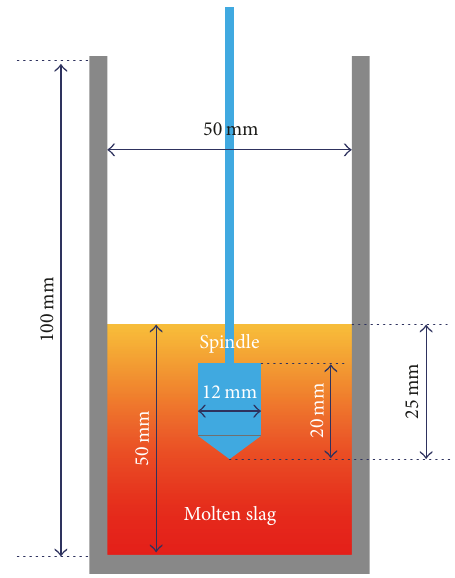
Figure 2: Dimensions of the spindle and bob in the present work.